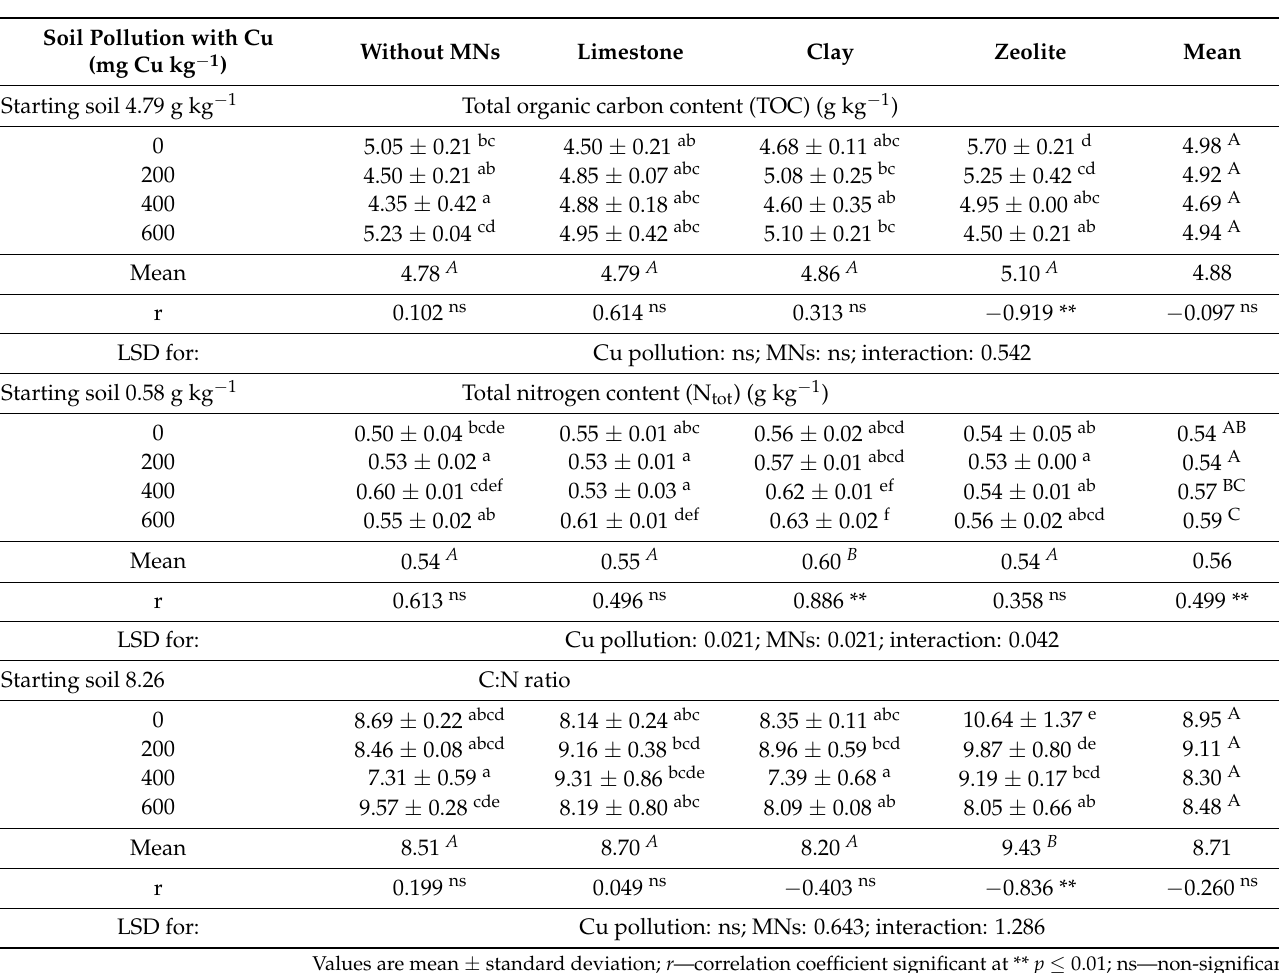
Table 3. Total organic carbon, total nitrogen content, and C/N ratio of the soil after black mustard ( Brassica nigra L. Koch)